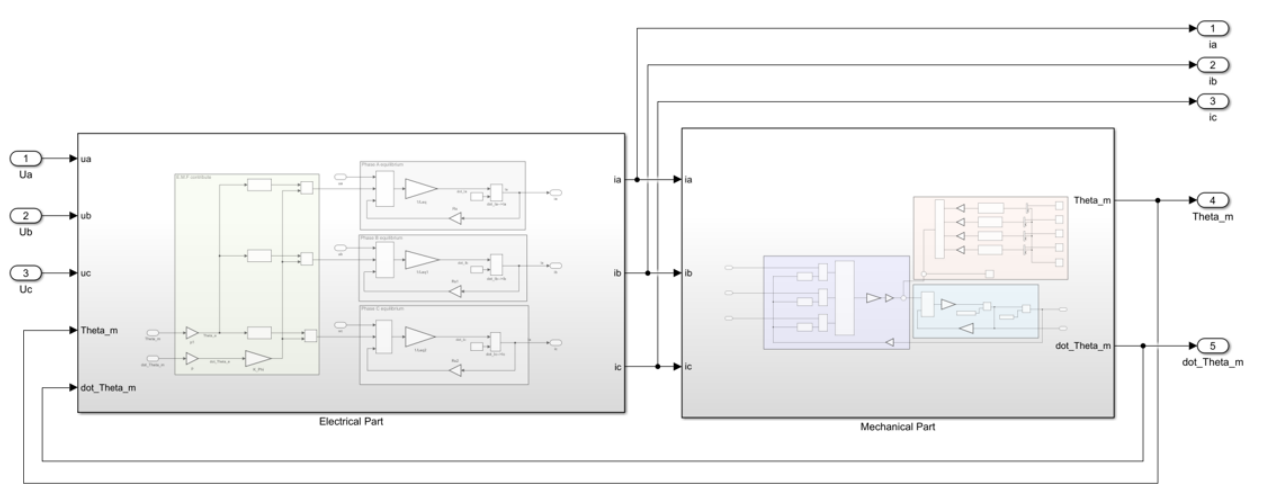
Figure 8. Implementation in Simulink environment of the dynamic interaction between electrical and mechanical